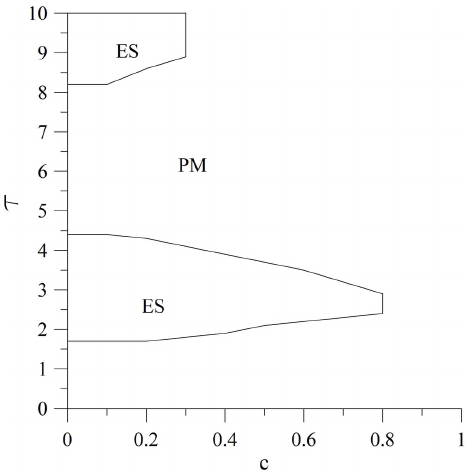
Fig. 4. Parameter domains ( τ,c) admitting equilibrium state (ES) or periodic motion (PM) at ν c = 1. Diagram refers to the single-block model, whereby the 0.1 step size is adopted for both c and τ .